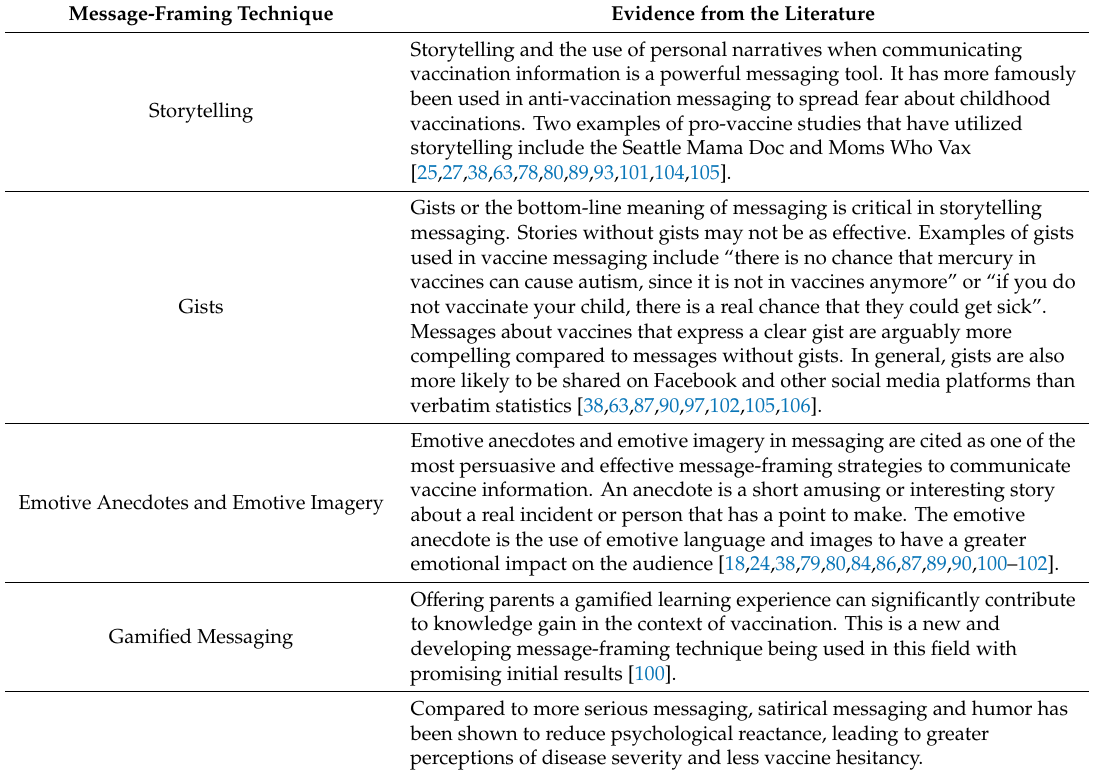
Table 7. Message-framing techniques for vaccination